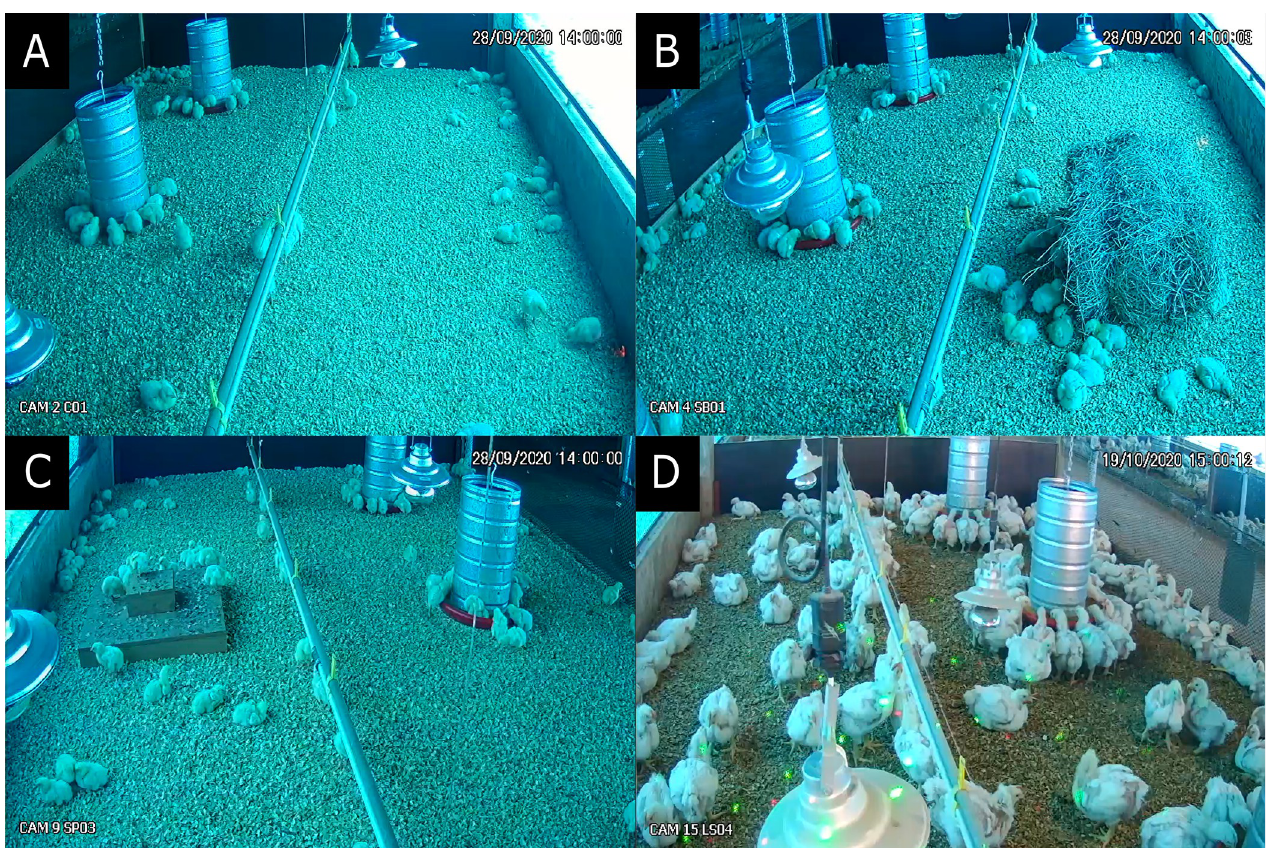
Fig 1. Broiler chickens housed in four environments. (A) Control, (B) Hay bale, (C) Step platform, and (D) Laser lights.